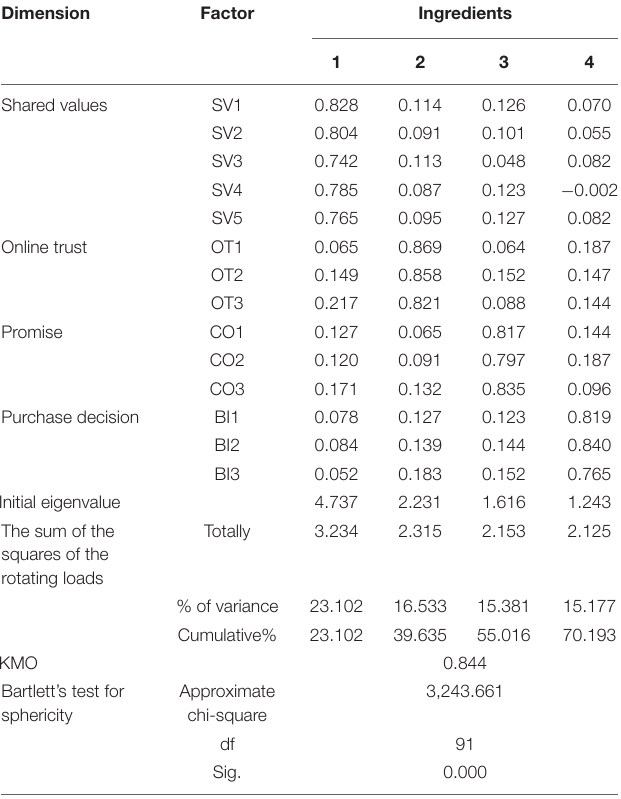
TABLE 2 | Factor load matrix.